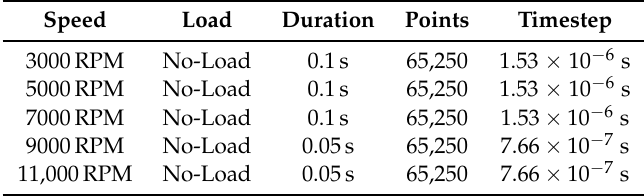
Table 5. Acquisitions summary.